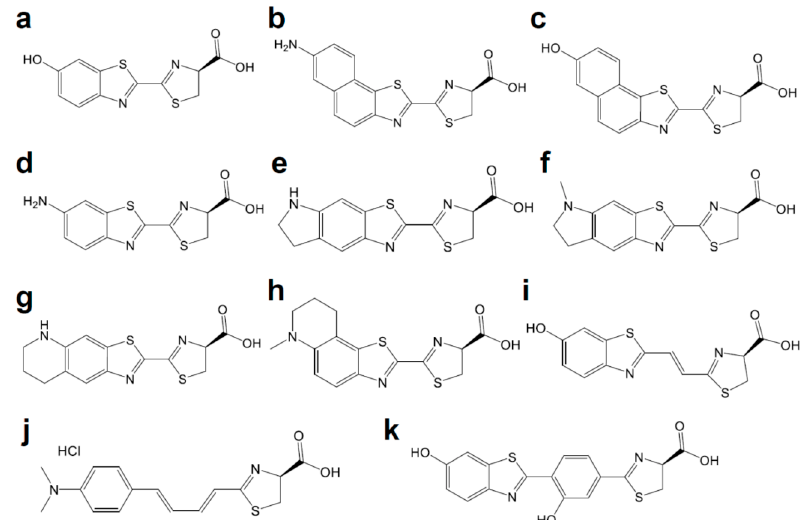
Figure 2. Chemical structures of d-luciferin and its red-shifted derivatives: ( a ) D -luciferin, ( b ) NH 2 -NpLH 2 , ( c ) OH-NpLH 2 , ( d ) 6 ′ -aminoluciferin, ( e ) CycLuc1, ( f ) CycLuc2, ( g ) CycLuc7, ( h ) CycLuc10 ( i ) Infra-luciferin, ( j ) Akalumine-HCl, ( k ) PhOH-Luc.